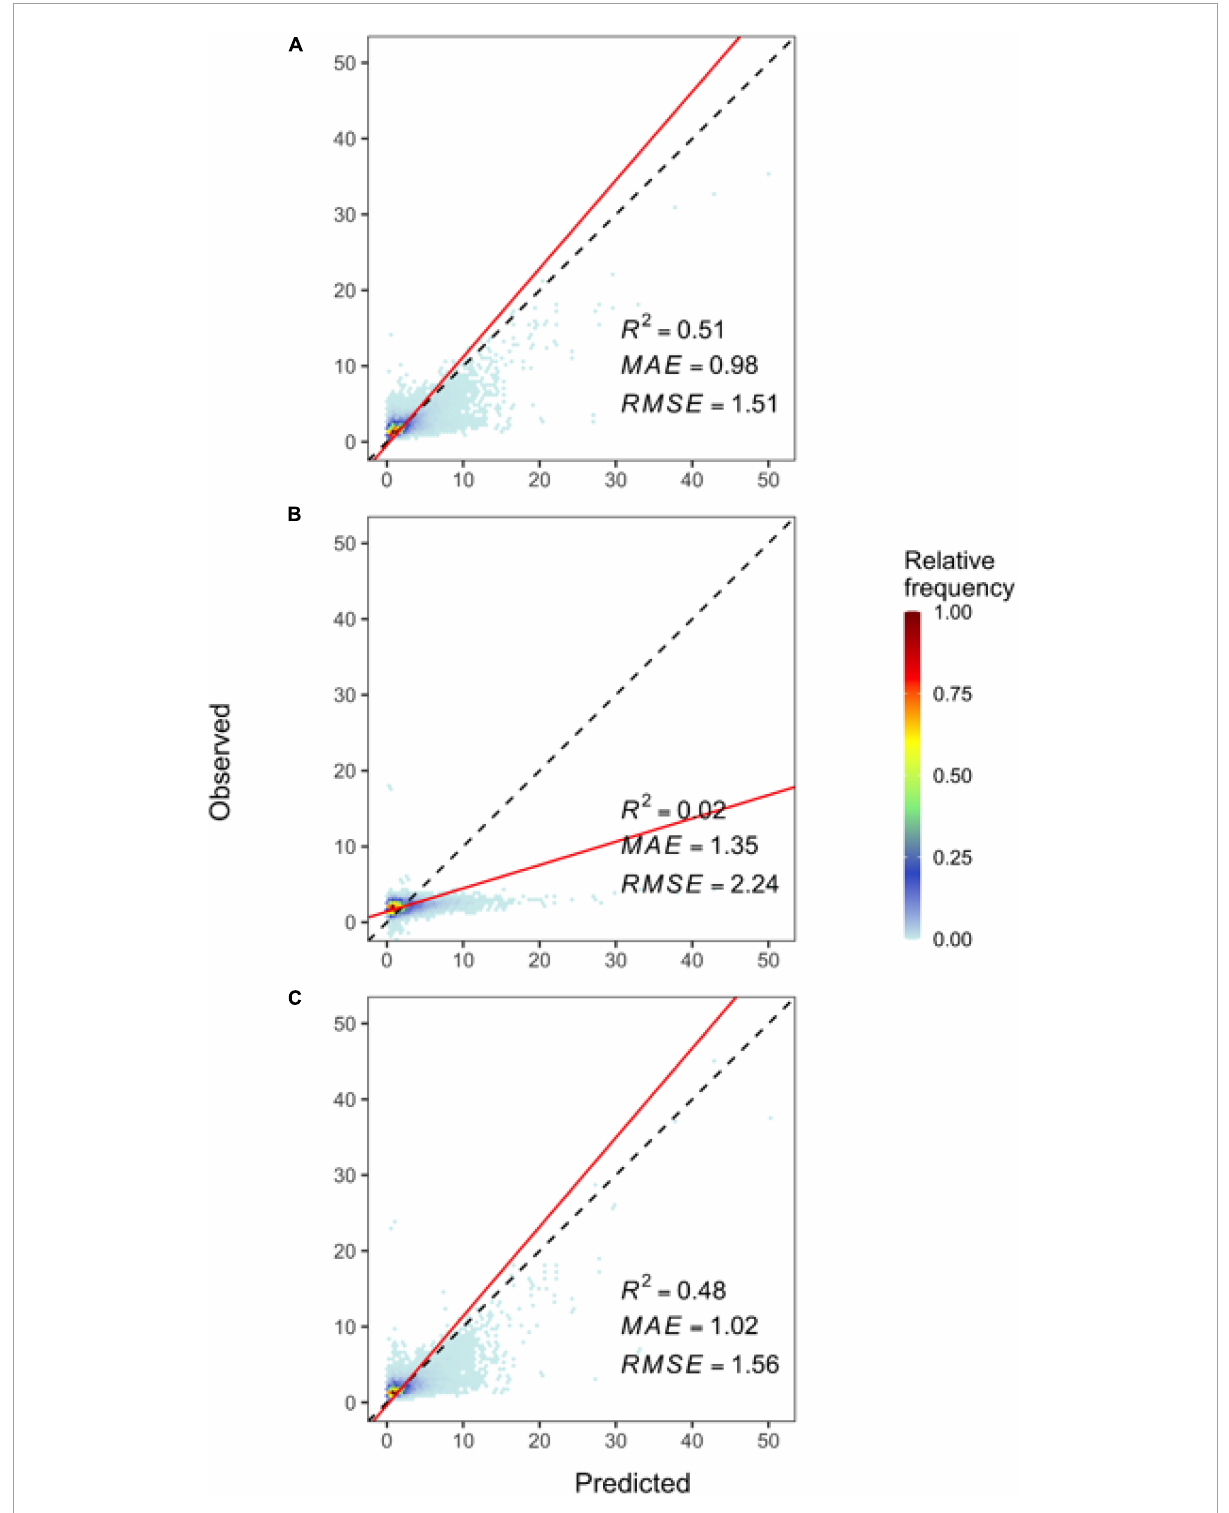
FIGURE1 Cross-validation of random forests model (A) versus multiple Linear Regression (B) and XGBoost (C) . Scatter plots show observed (vertical axis) vs. predicted (horizontal axis) basal area values (m 2 /ha), from which we calculated mean absolute error (MAE), root-mean-squared error (RMSE), and the coefficient of determination ( R 2 ) of the trendlines (red) between the predicted and observed values. The broken lines represent the perfect fit where predicted values match observed values.